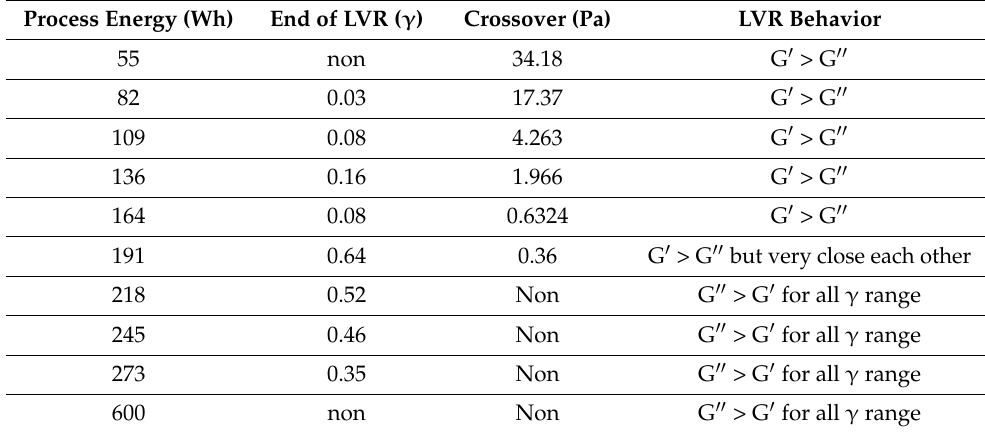
Table 2. LVR values and crossover point (Pa) for SWCNT dispersion samples.